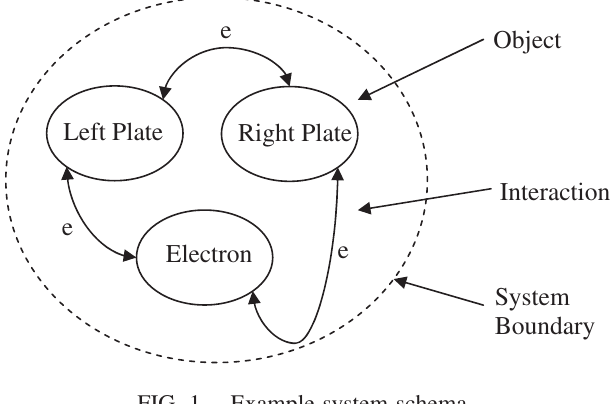
FIG. 1. Example system schema.